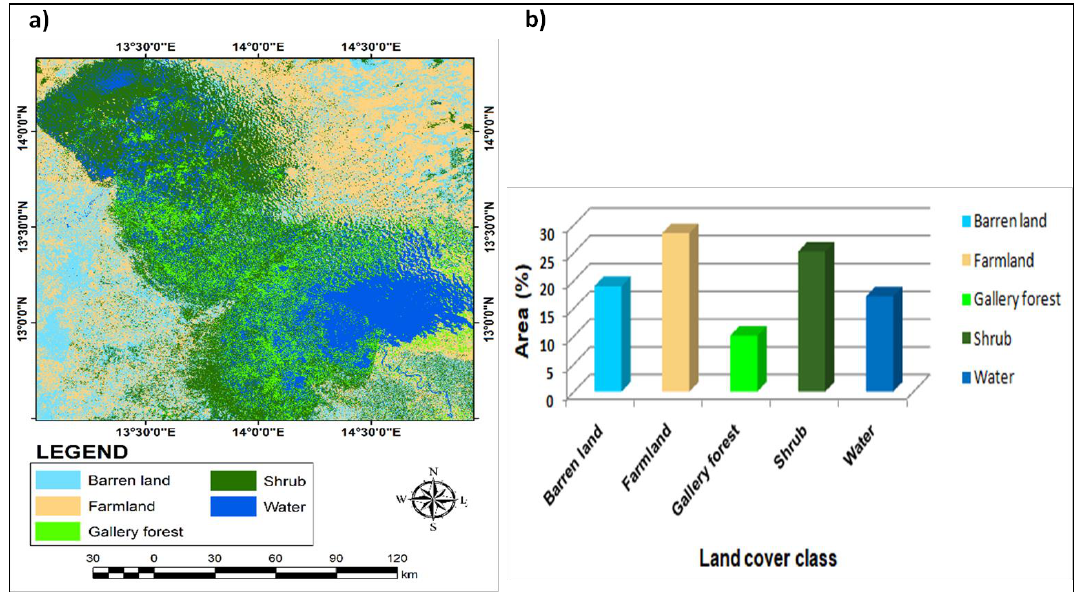
Figure 3. (a) Lake Chad change map in 1985, (b) area coverage percentage for each class